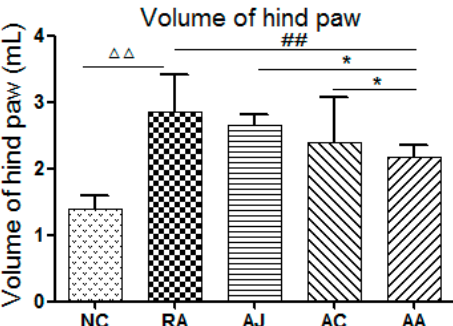
Figure 1. Hind paw volumes of the rats. (NC, control group; RA, model group; AC, Aconitum carmichaeli -treated RA group; AJ, Ampelopsis japonica -treated RA group; AA, Aconitum carmichaeli + Ampelopsis japonica -treated RA group, △△ p < 0.01 RA vs. NC; ## p < 0.01 AA vs. RA; * p < 0.05 AC/AJ vs. AA).